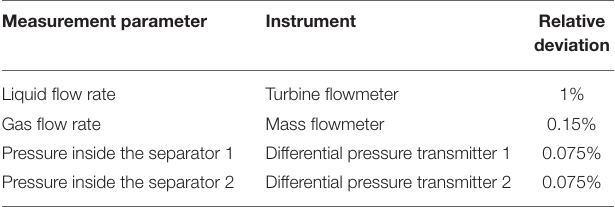
TABLE 1 | Measurement parameters and relative deviation of